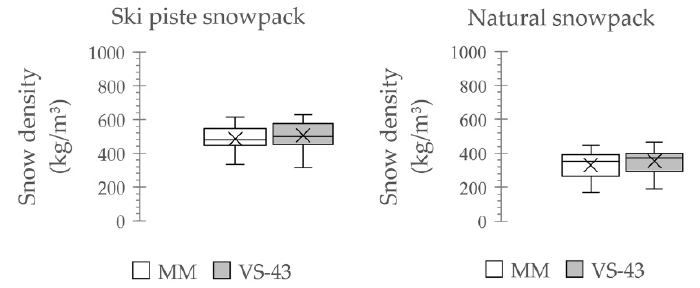
Figure 3. Comparison of 30 paired measurements of the snow densities of ski piste and uncompacted natural snow measured by designed MM snow tube versus the VS-43 snow tube.